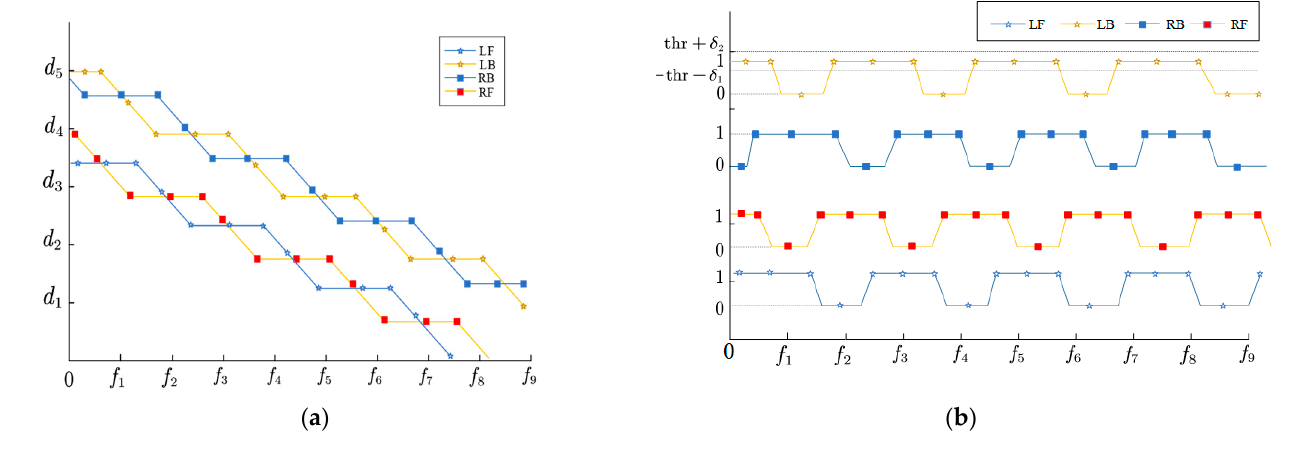
Figure 6. ( a ) The feet-end displacement curve of a quadruped animal; ( b ) the first-order differential curve of feet-end displacement.